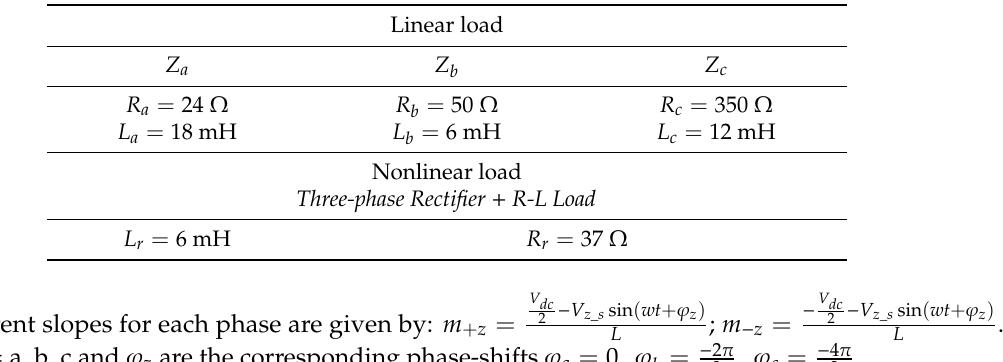
Table 1. Load values.